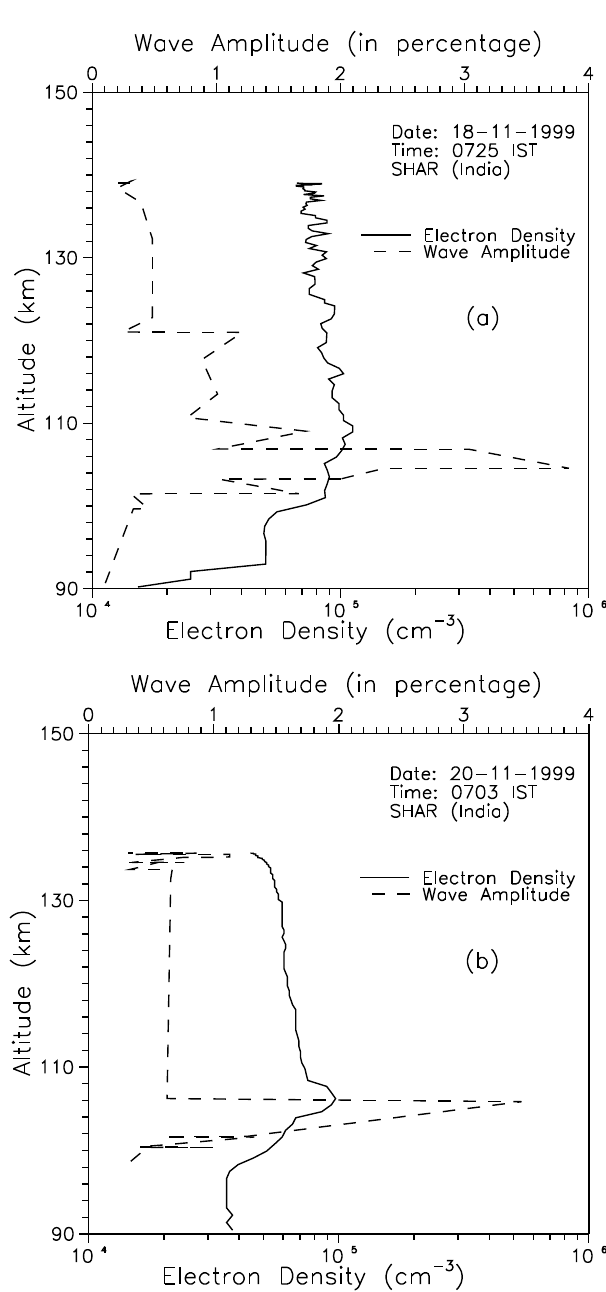
Fig. 3. Altitude profiles of amplitude of plasma waves along with electron densities obtained ( a ) on 18 November 1999, ( b ) on 20 November